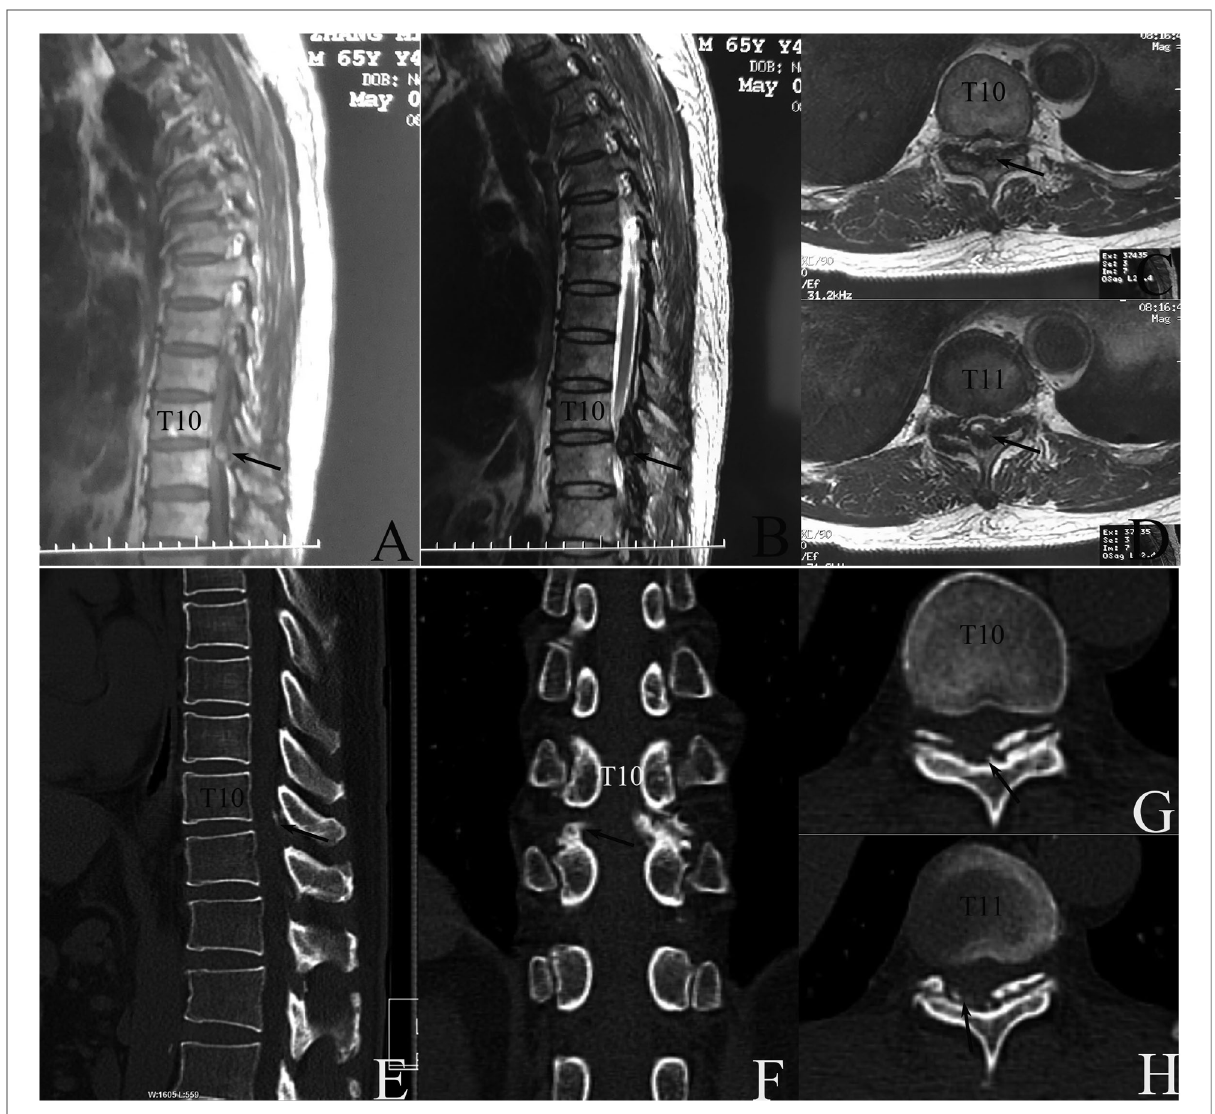
FIGURE 1 Preoperative image examinations. ( A – D) Magnetic resonance (MR) taken on 2 May 2019 detected a dorsal epidural compression at T10 – 11 interlaminar level. ( A ) midsagittal T1WI image; ( B ) midsagittal T2WI image, and transverse T2WI image at T10 ( C ) and T11 ( D ) levels. ( E – G ) Computed tomography (CT) taken on May 6 revealed intraspinal canal calci fi cation deposits posterior to the spinal cord at the T10 – 11 level which had no continuity with the lamina. Midsagittal ( E ), coronal plane ( F ), and transverse CT image at T10 ( F ) and T11 levels ( G ) on bone window,